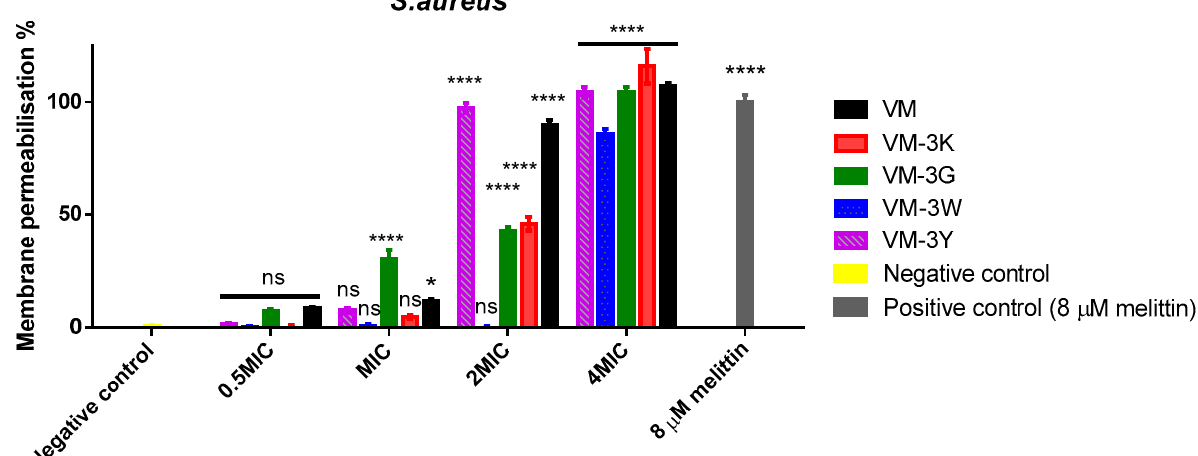
Figure 3. Cell membrane permeabilization effects of peptides against S. aureus . Peptide concentrations were 0.5 × MIC, 1 × MIC, 2 × MIC and 4 × MIC. Bacteria incubated in relevant broth were treated as the negative control, and 8 µ M melittin acted as the positive control. Data points represent mean ± SEM of nine replicates from three independent experiments. The statistical significance was analysed using two-way ANOVA with Dunnett’s multiple comparisons test in GraphPad Prism software by comparison with the negative control. The significance is indicated by asterisks (* p < 0.05; **** p < 0.0001), and ns represents no significant difference.